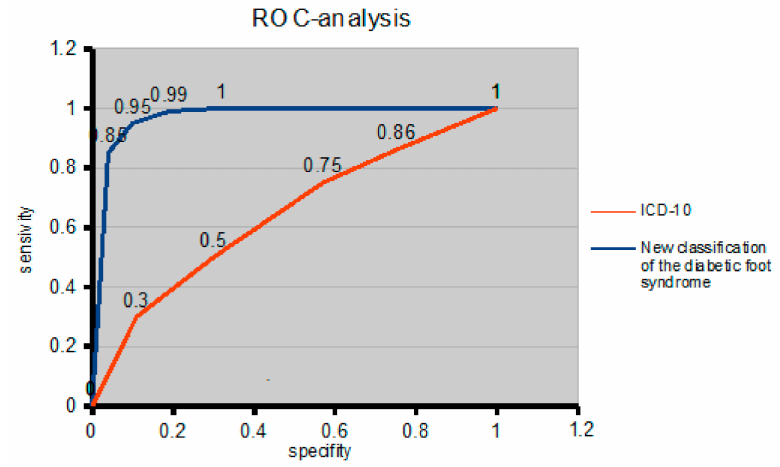
Figure 5. ROC curve to compare the effectiveness of the presence of diabetic foot syndrome in the diagnosis of the ICD-10 and the proposed diabetic foot syndrome classification.